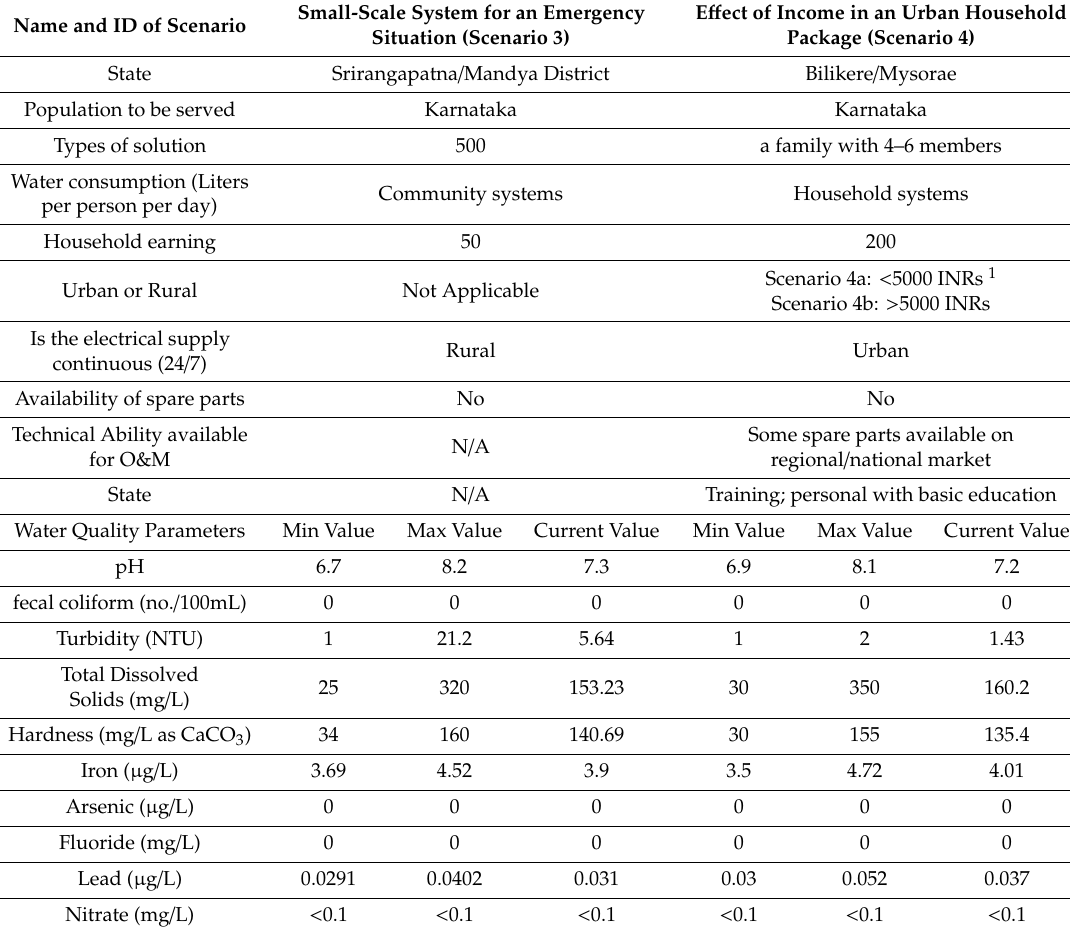
Table 3. Main information / assumption on the decentralized